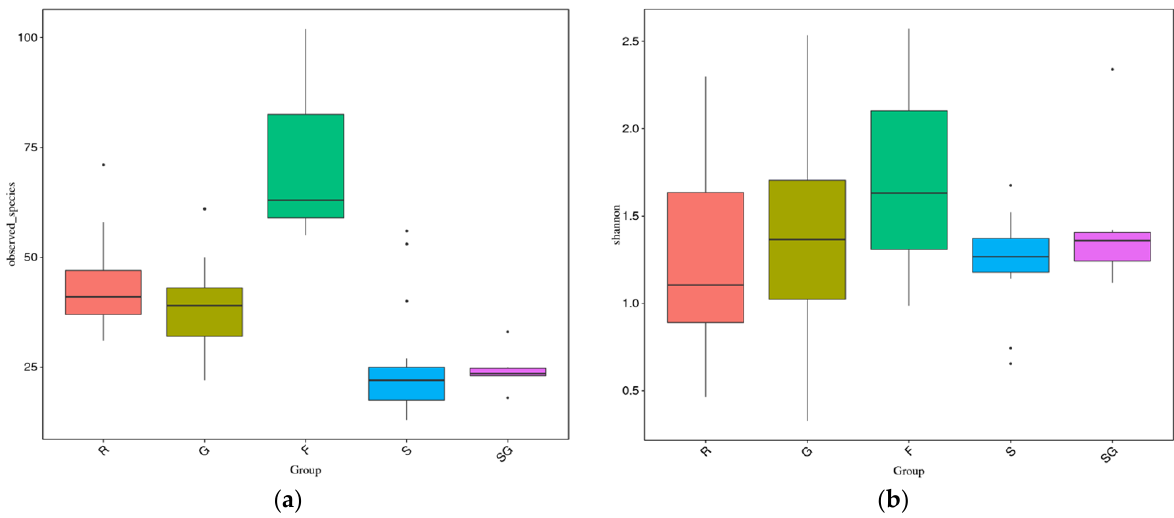
Figure 2. Box plots of fungal species richness ( a ) and Shannon indices ( b ) in the five different HTS ITS amplicon groups. R = Roosky leaves, G = Glasnevin leaves, F = France leaves; S = Roosky seeds, SG = Glasnevin seeds. All pairwise species richness comparisons were significantly different ( p < 0.05) with Tukey tests except R-G, SG-G, and SG-S; and for Wilcoxon tests, all were significantly different ( p < 0.05) except for R-G and SG-S. For the Shannon index values, none of the pairwise comparisons were significantly different with either the Tukey or Wilcoxon tests.